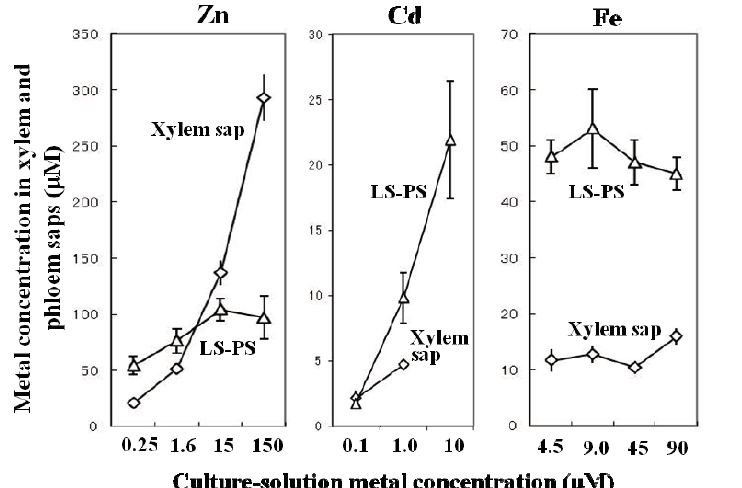
Figure 3. Metal concentrations in the xylem and phloem saps of vegetative rice plants under various culture-solution metal concentrations. Phloem sap was collected from the leaf sheaths (LS-PS) of the 7th leaves. Data for Zn and Fe are from Nishiyama [41], and data for Cd are from Mariyo Kato